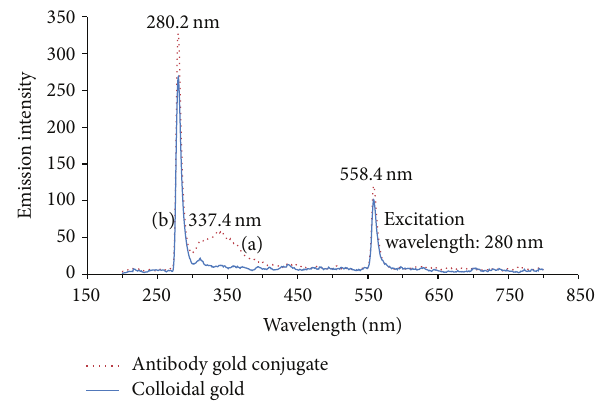
Figure 6: Fluorescence spectra of the MAb-gold conjugate and colloidal